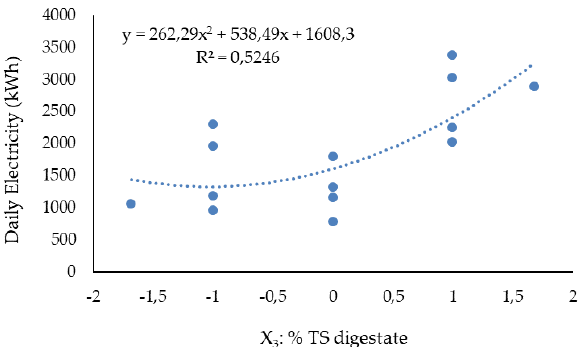
Figure 3. Representation of daily electricity production at different levels of sludge dewatering for scenario 1.